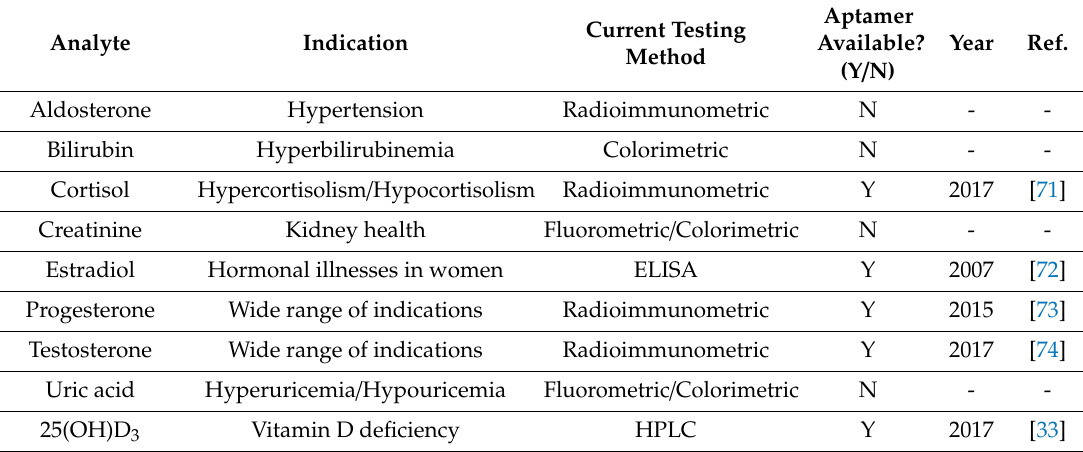
Table 3. Selection of relevant small molecules measured in health monitoring. The current state-of-art testing method is mentioned, as well as whether an aptamer against the analyte is available or